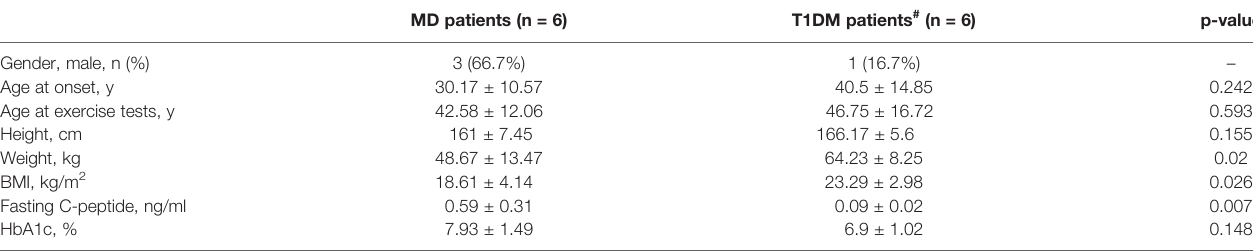
TABLE 2 | Demographic characteristics of MD patients and T1DM patients.